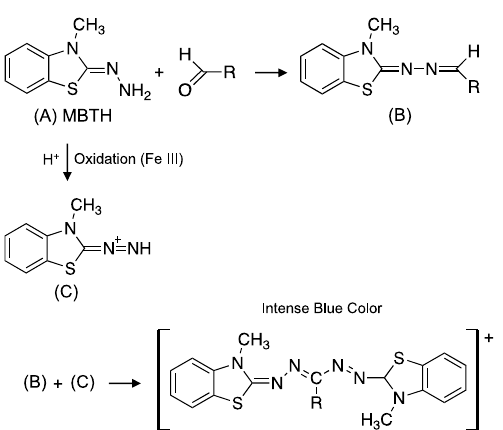
Figure 4. Reaction of MBTH with aldehydes to form an intense blue-colored complex. Figure adapted from Reference [131] (Copyright 2016, Elsevier).